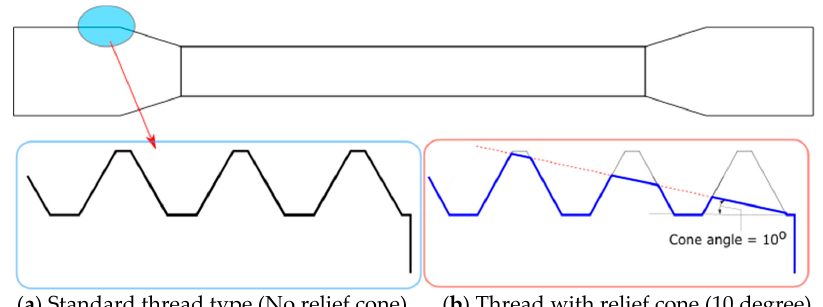
Figure 3. Geometry of nut and bolt.